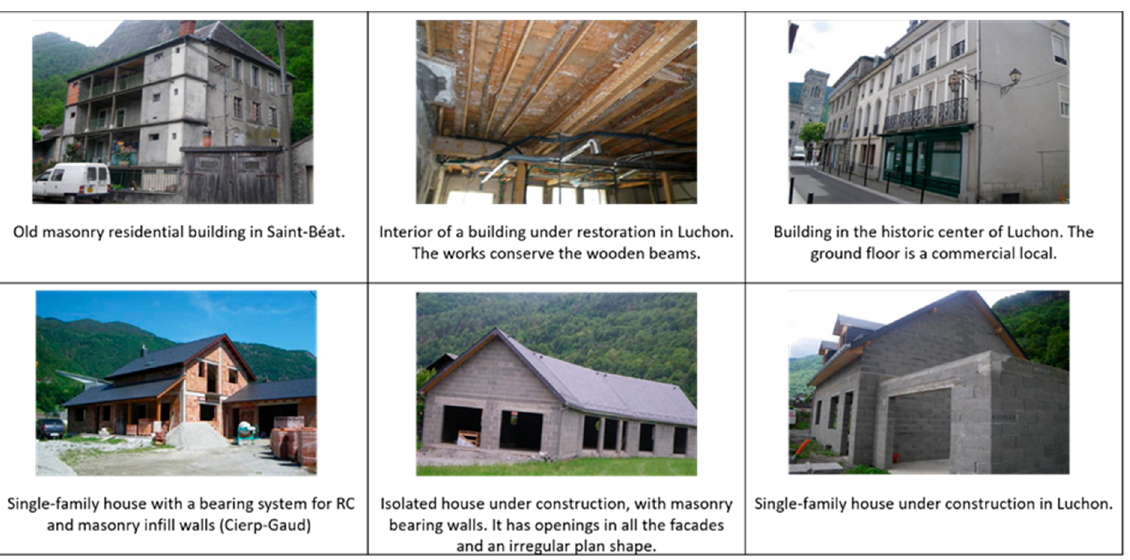
Figure A1. Examples of the main building types found in Bagnères-de-Luchon sector.